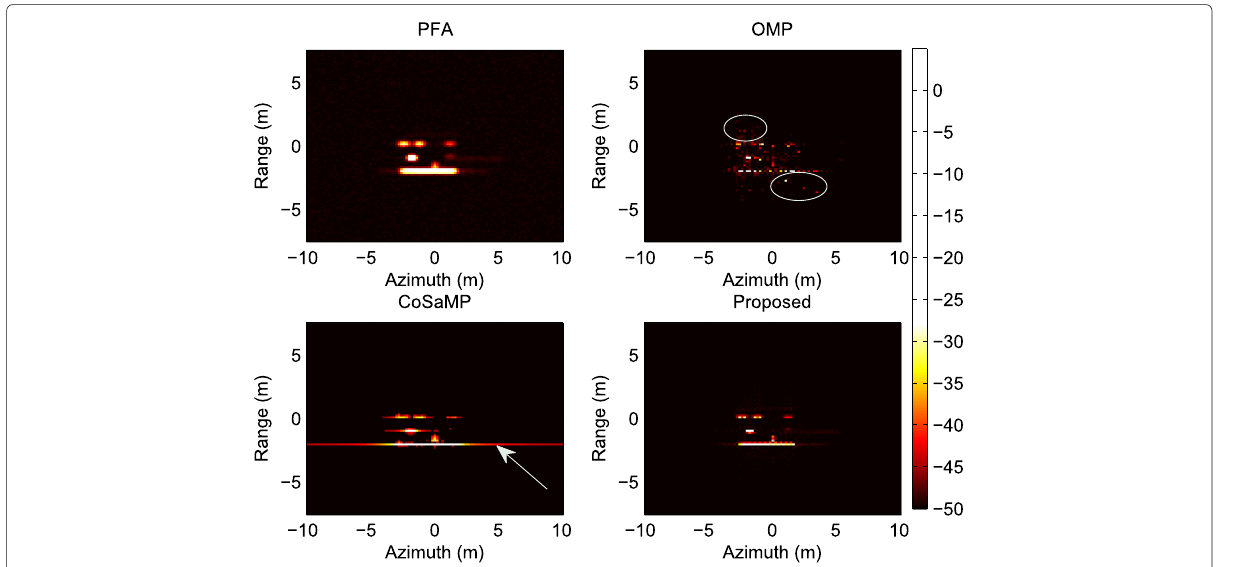
Fig. 5 SAR imaging for practical measured data, φ = 90 ◦